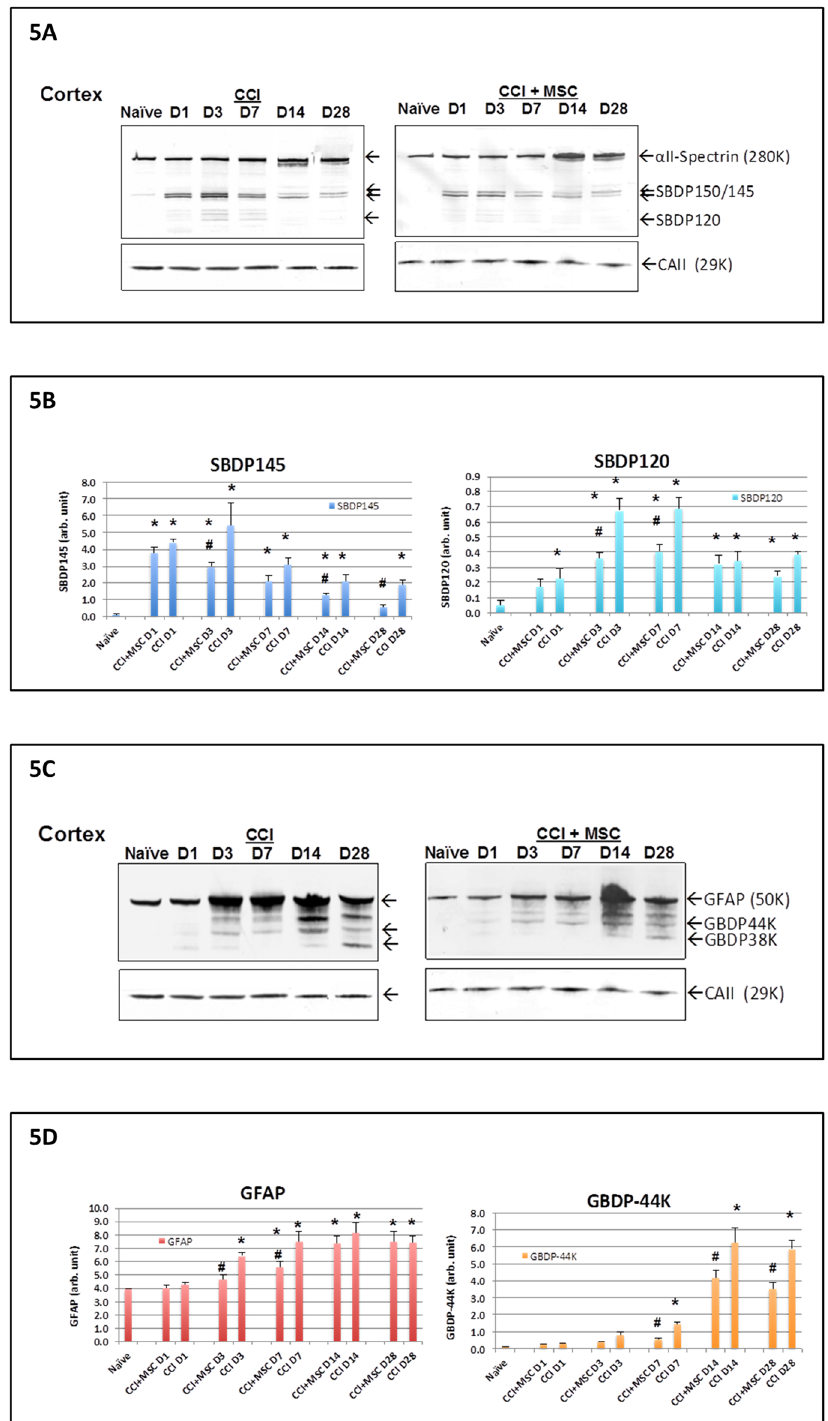
Figure 5. Expression of biomarkers in penumbra cortex in rats with and without MSC treatment after TBI. Effects of MSC topical transplantation on proteolytic neuronal and glial injury biomarker levels in the ipsilateral cortex axonal alphaII-spectrin breakdown product SBDP biomarkers levels at different time points after controlled cortical impact (CCI) injury with or without MSC topical transplant are shown. ( A ) showed representative blots of spectrin and house-keeping gene loading control (Carbonic anhydrase II, 29 kDa). ( B ) showed quantification of biomarkers (equalized by CA-II band intensity). GFAP and GFAP-breakdown product GBDP biomarkers levels at different time points after controlled cortical impact (CCI) injury with or without MSC topical transplant were shown ( C , D ) shows representative blots of GFAP and house-keeping gene (Carbonic anhydrase II, 29 kDa). Quantification of comparison: * higher than naïve group; # MSC + CCI treatment group was different from CCI alone group at same time point (p < 0.05). MSC + CCI vs. CCI group-based ANOVA results were stated in the